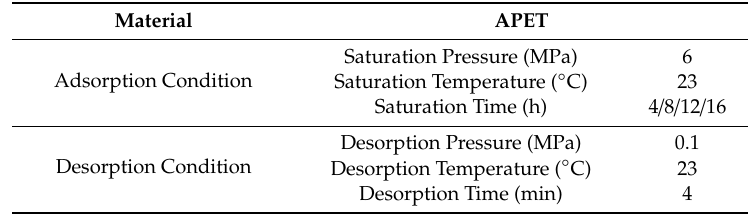
Table 2. Experimental conditions used for studying changes in tensile strength.